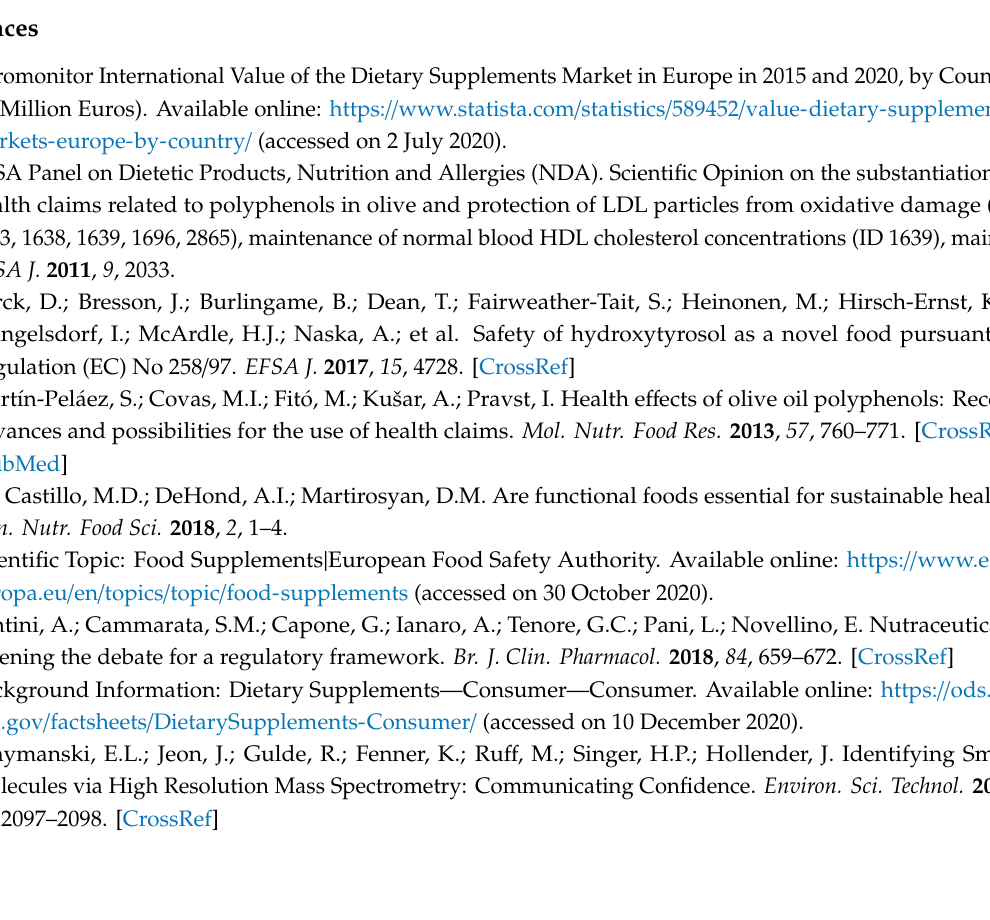
Table S1: Unknown compounds detected in study samples, Table S2: MS / MS fragments of detected compounds by LTQ-Orbitrap, Figure S1: Scores plots of the samples in the space described by the first two principal components based on data obtained in untargeted analysis, Figure S2: Heat map of discriminant features according to the part of the plant used, Figure S3: Boxplots of selected compounds characteristic of products made from a particular part of the olive plant, Figure S4: Pie charts of the total amount of compounds by product, Figure S5: Pie charts of the proportion of phenolic and non-phenolic compounds present in each product, Table S3: Estimated daily intake (mg / day) of the quantified compounds according to the recommended dose, Table S4: Parameters used for data processing with XCMS, Table S5: Analytical standards used for the targeted